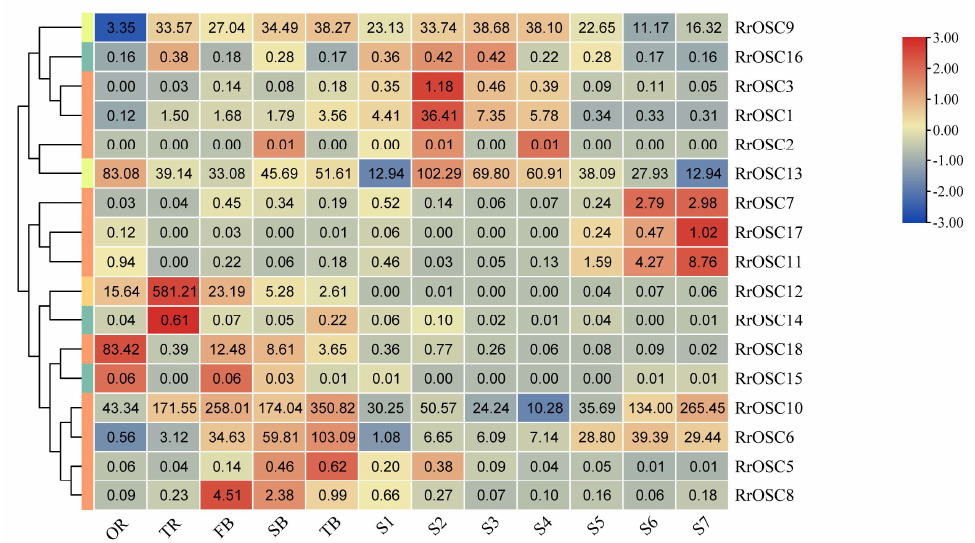
5 of 11 Figure 3. Chromosomal localization ( a ) and tandem duplication ( b ) analysis of RrOSCs . Blue lines indicated the duplication gene pairs according to the synteny analysis. 2.4. Expression Analysis of RrOSCs To detect the candidate RrOSC genes of the synthetic pathways of R. rugosa active